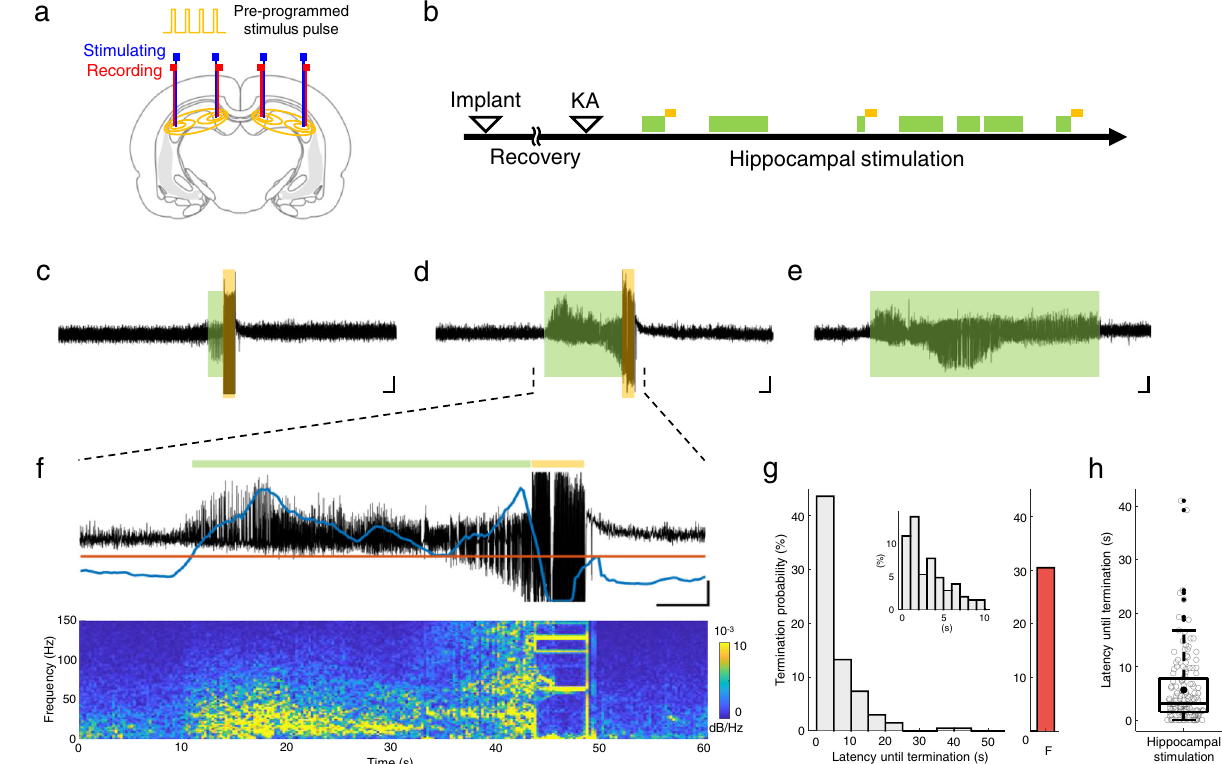
Fig. 2 | Seizure control in a KA-induced SE model via overall hippocampal intervention.a Schematicdepictingtheinsertionpositionsofthedepthelectrode andthestimulationpattern. b Experimentaltimeline. c – f Representativerecording results of electrographic seizures with hippocampal control in c and d or without control in e (seizures detected: green boxes; electrical stimulus: vertical orange line). f Excessive spontaneous spike-wave discharges detected by the algorithm (top; current index: blue line; threshold: orange line) and their corresponding power spectrum (bottom; using a 0.5s sliding window with 50%